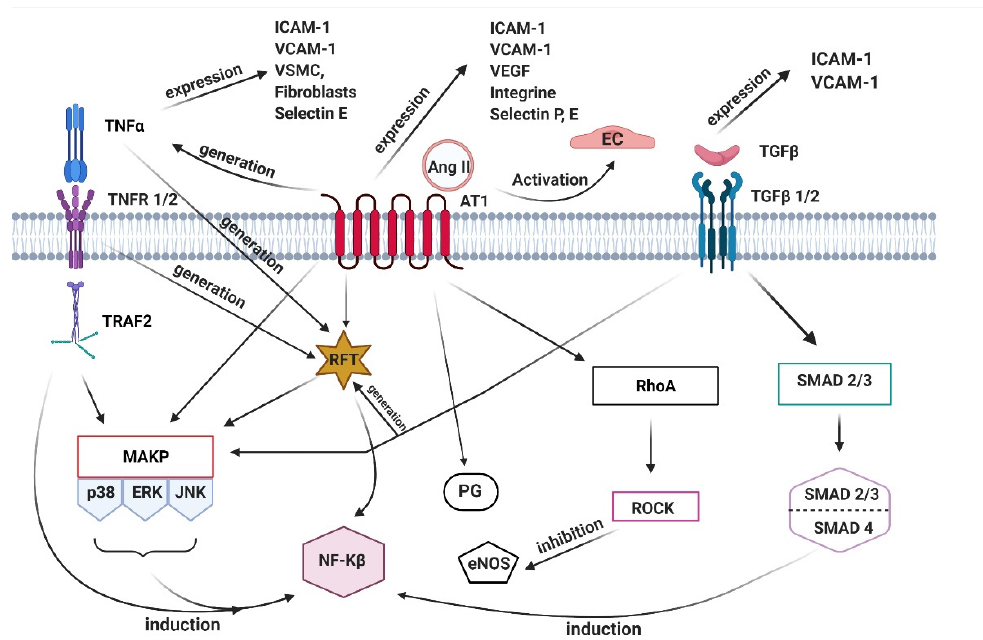
Figure 2. The molecular pathways of the aneurysms formation. One of the inducers of inflammation is angiotensin II (Ang II). It is a peptide hormone, which promotes a proinflammatory, profibrotic, and proliferative effect. This activates EC and induces expression of vascular endothelial growth factor (VEGF), intercellular adhesion molecule 1 (ICAM-1), vascular cell adhesion molecule 1 (VCAM-1), selectins, and integrins. Studies have shown that Ang II, by stimulating the synthesis of prostaglandin (PG) and ROS, modulates microvascular permeability. Consequently, Ang II is involved in the vasodilation mechanism and thus plays an important role in blood pressure regulation. RhoA pathway activation is responsible for barrier dysfunction in the vascular EC (Yao et al., 2010). Moreover, it has been shown that it is involved in the inhibition of the expression of endothelial nitric oxide synthase (eNOS). Interestingly, the binding of AngII to its AT1 receptor in arteries and arterioles induces the production and release of TNF α